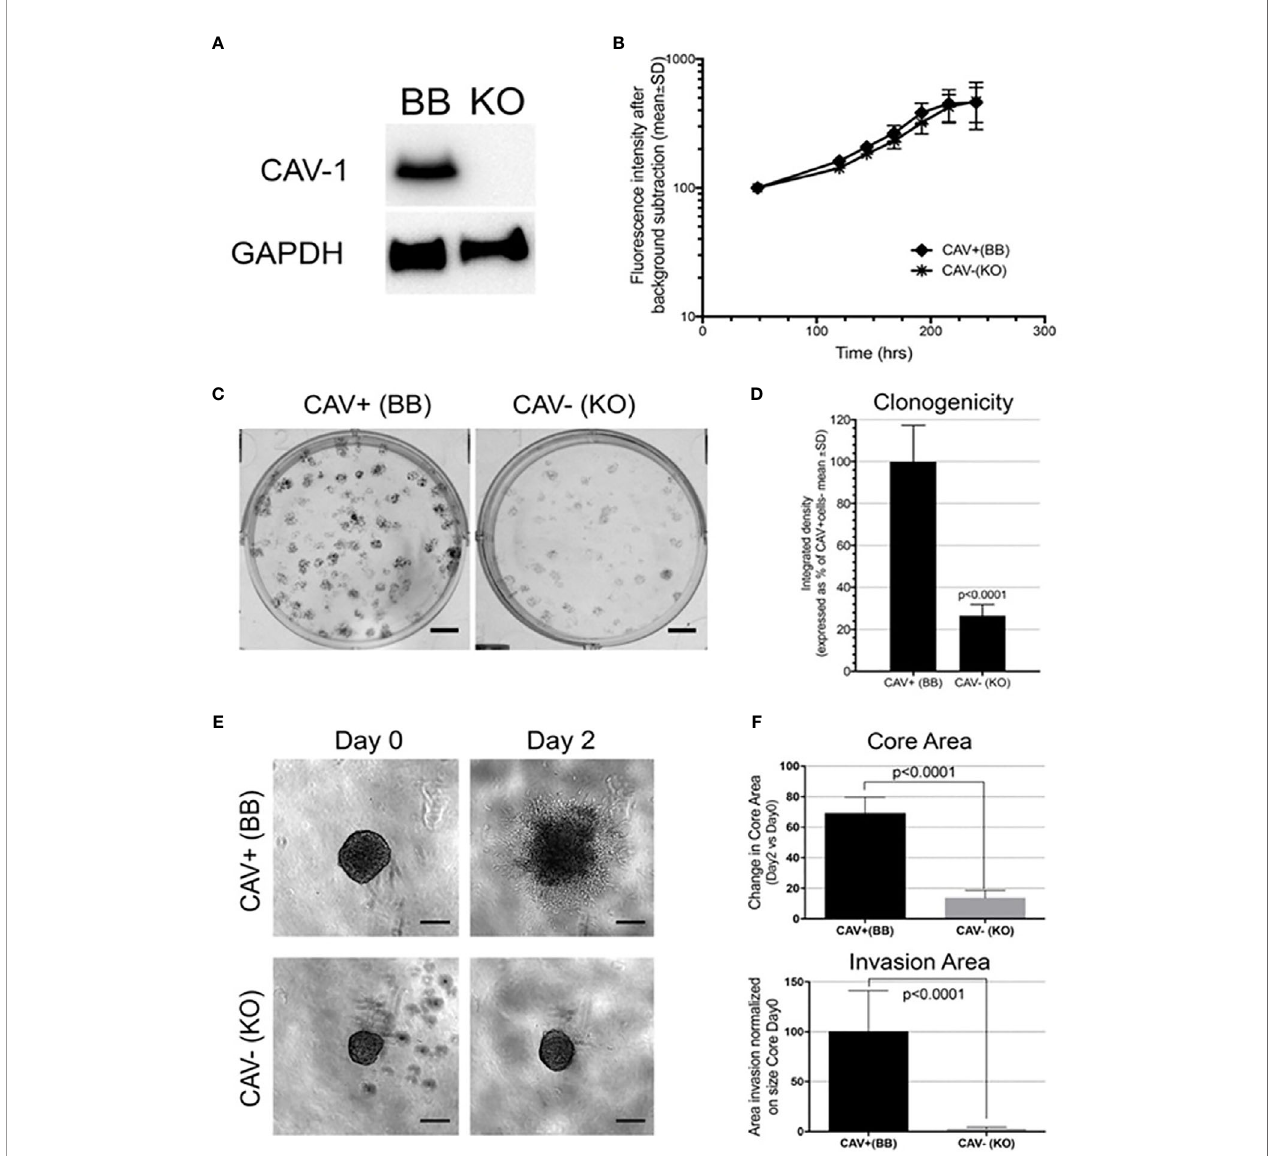
FIGURE 7 | Cav-1 knockout (KO) and impact on the in vitro aggressiveness of the GB cell line U87: (A) Western blot for Cav-1 in the U87 cell line bearing genetic CRISPR deletion of Cav-1 (designated KO) compared to the Cav-1 positive control (designated BB). GAPDH was used as reference housekeeping gene. (B) ; Proliferation curves of U87 Cav-1 +ve (BB) and U87 Cav-1 -ve (KO); (C, D) Clonogenicity assay with 7-day colony formation on agar U87 Cav-1 +ve (BB) vs Cav-1 -ve (KO) Representative images are shown in (C) . Scale bar 500 µm. Quanti fi cation is shown in (D) ; (E, F) 3D in-vitro invasion assay. In 7E representative images of U87 Cav-1 +ve (BB) vs Cav-1 -ve (KO) spheroids embedded within Matrigel (Day 0) and the spheroid cell invasion after 2 days in Matrigel (Day 2). Scale bar 200 µm. In 7F quanti fi cation of the change (Day 2 vs Day 0) in the spheroid Core Area (top) and the spheroid area of the invasive edge (normalized to the perimeter of the core (bottom). This analysis undertaken as described previously using INSIDIA analysis software